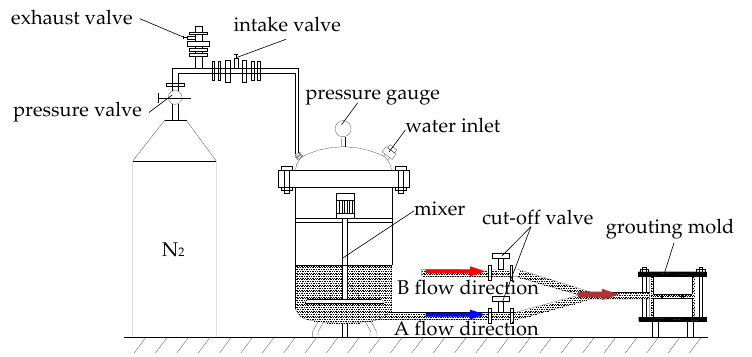
Figure 3. Grouting system of pressure-retaining for structural face rock specimen.